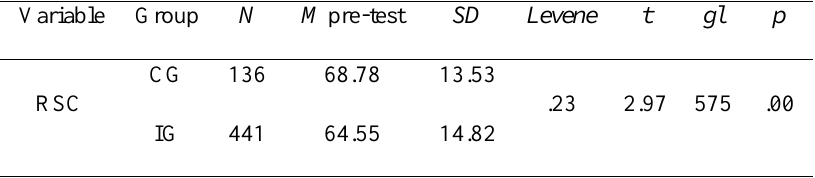
Reading Self-Concept (RSC) pre-test results in CG and IG